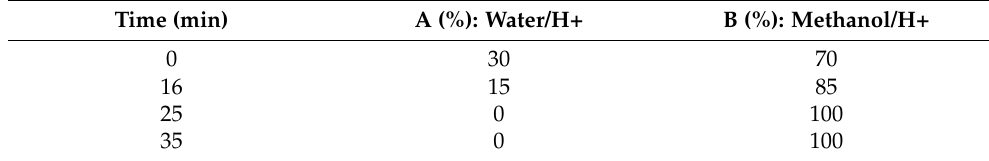
Table 2. HPLC gradient for sample